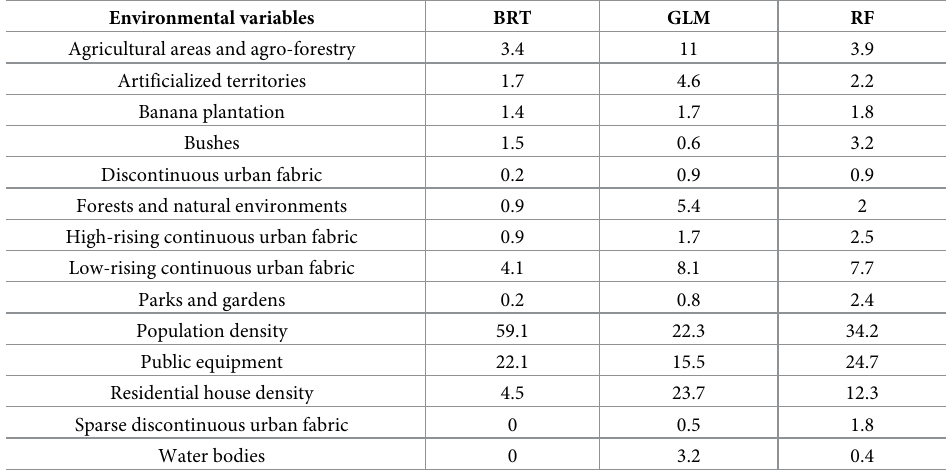
Table 3. Relative influence of predictor variables in models of suitability of land use and human settlement condi- tions for boosted regression trees (BRT), generalized linear models (GLM) and random forests (RF). Generalized additive models were not used as the number of distribution records was insufficient for model